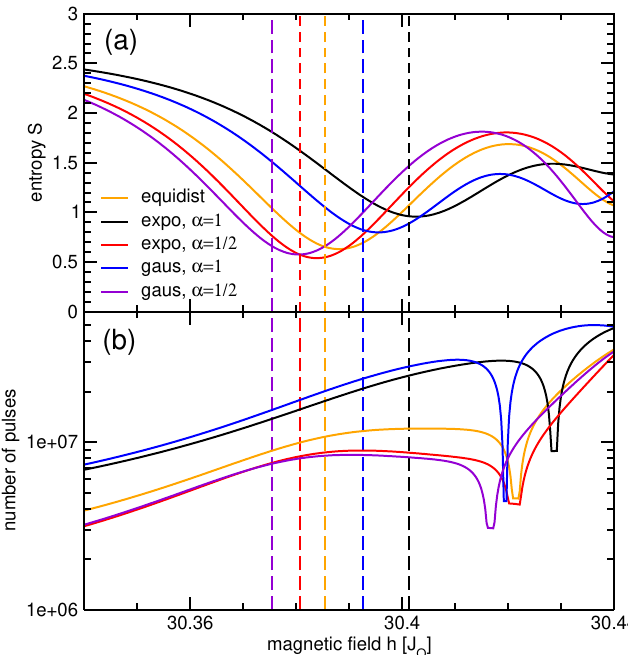
Figure 5: Residual entropies (panel a) and number of pulses (panel b) for a conver- = 0.01) for N = 3, J = 0.1 J gence within 1% ( p , and z = 0.1 for the equidis- thresh max Q tant parametrisation in (8) (legend “equidist”), the exponential parametrisation in (9) (legend “expo”) and the Gaussian parametrisation in (10) (legend “gaus”). The vertical dashed lines indicate the estimates for the entropy minima which are shifted from the resonances without interactions according to